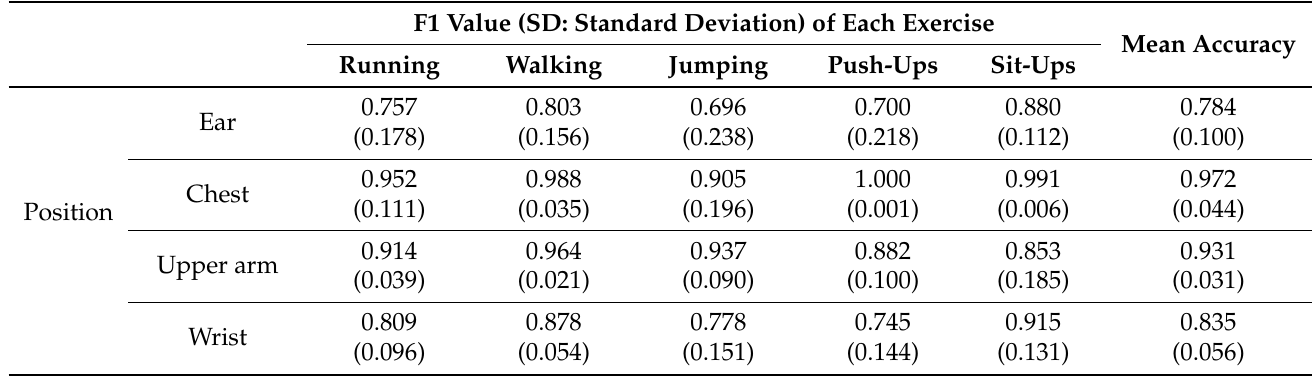
Table 4. Leave-one-subject-out cross-validation accuracy of conventional machine learning methods (linear SVM